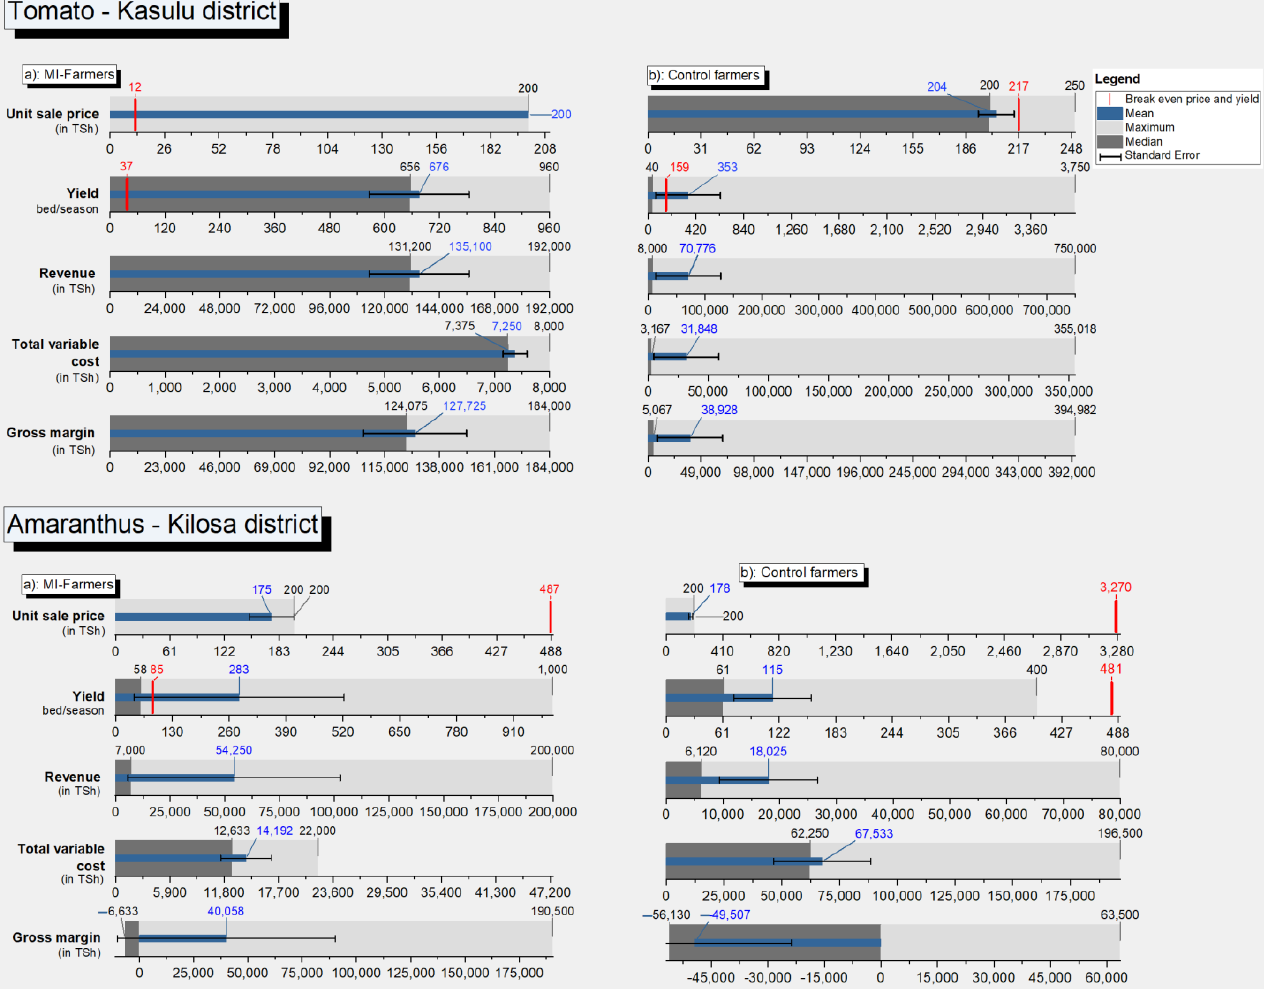
Figure 6. Enterprise comparison of MI farmers ( a ) and control farmers ( b ) growing tomatoes (Kasulu district) and Amaranthus (Kilosa district). Price, revenue, total variable cost (TVC), and gross margin (GM) amounts are presented in Tanzanian Shilling (TSh), where 1 USD = 2330 TSh and 1 TSh = 0.00043 USD. Yield is calculated as per bed per season. Standard error of mean is presented as error bars for each bar graph.